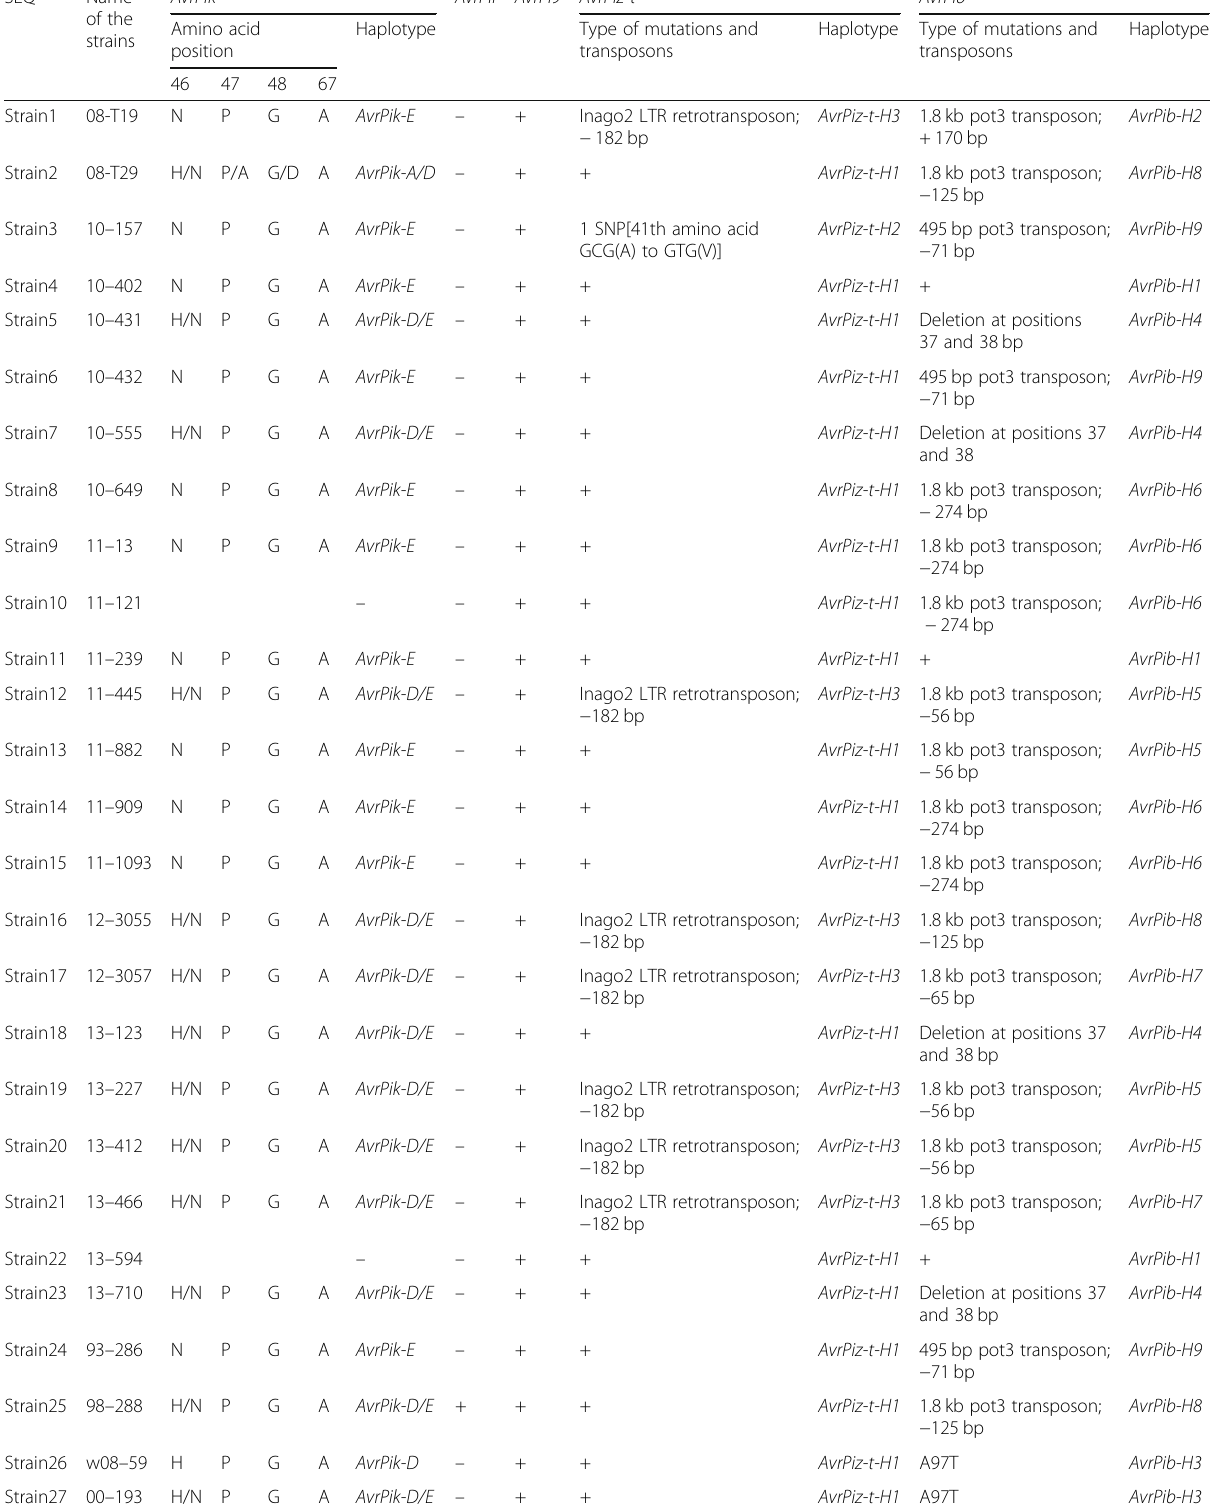
Table 2 Haplotypes of 5 avirulence ( Avr ) genes in 27 isolates. +: Identical to the respective Avr gene; − : Do not contain the respective Avr gene; LTR: long terminal